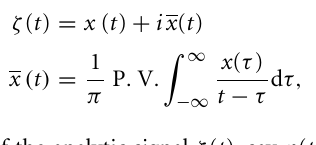
desynchronizations. Whenever trajectory leaves synchronized region I, it follows the path II-IV-I and returns back to the synchronized state in